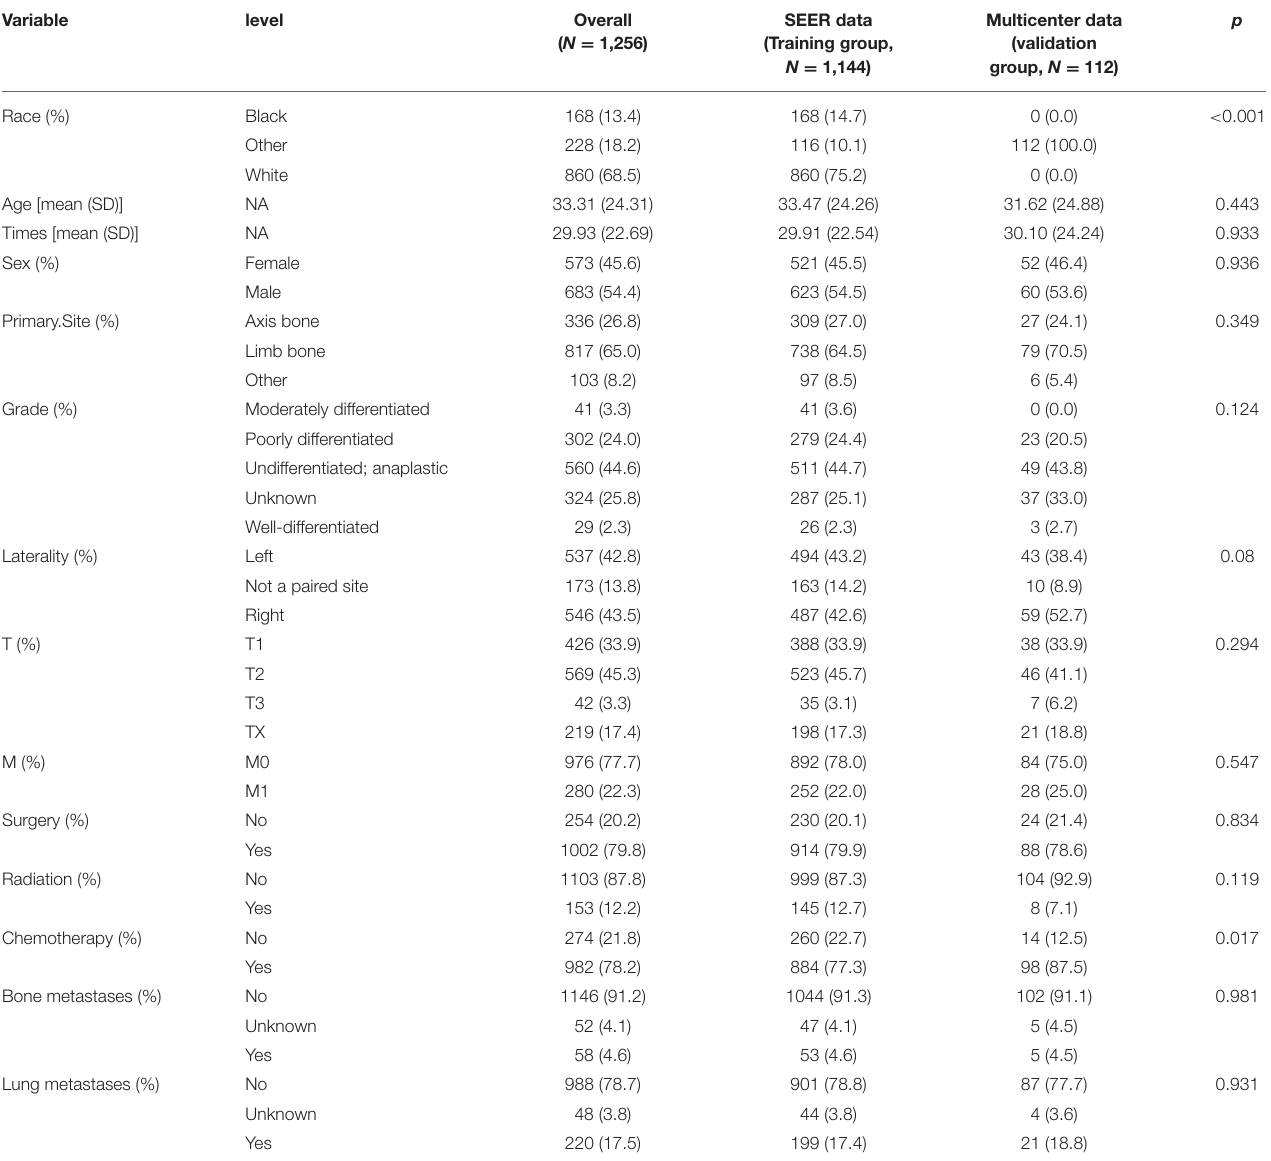
TABLE 1 | Baseline data table of the training group and the validation group. Variable